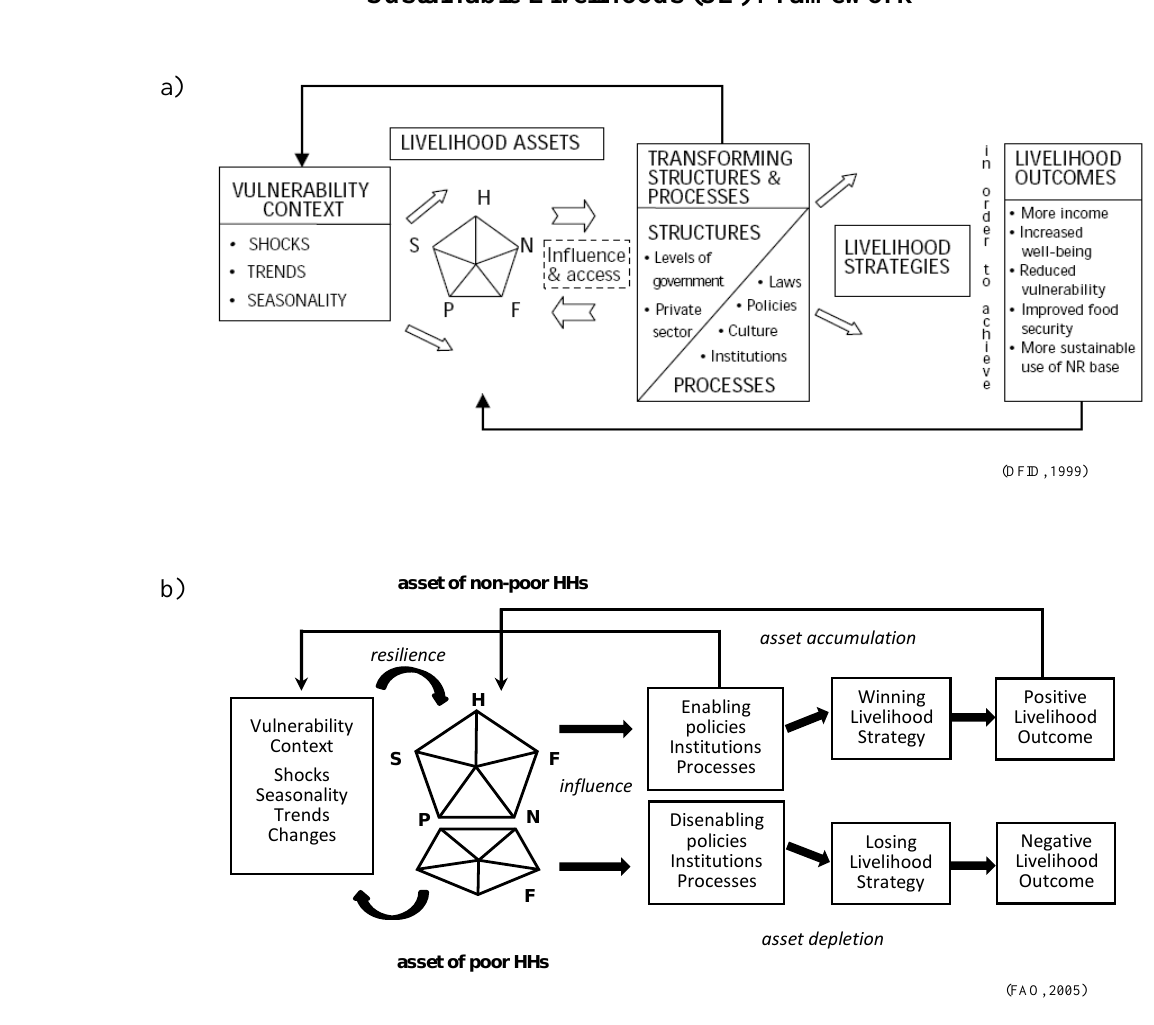
Figure 1. (a) Basic model (DFID, 1999), where H is human capital, N is natural capital, F is financial capital, P is physical capital, S is social capital. (b) Illustration of assets balance for poor vs. nonpoor households as suggested by FAO (2005), where assets above are shown in reference to enabling and/or disenabling transformative structures and processes (policies, institutions, and